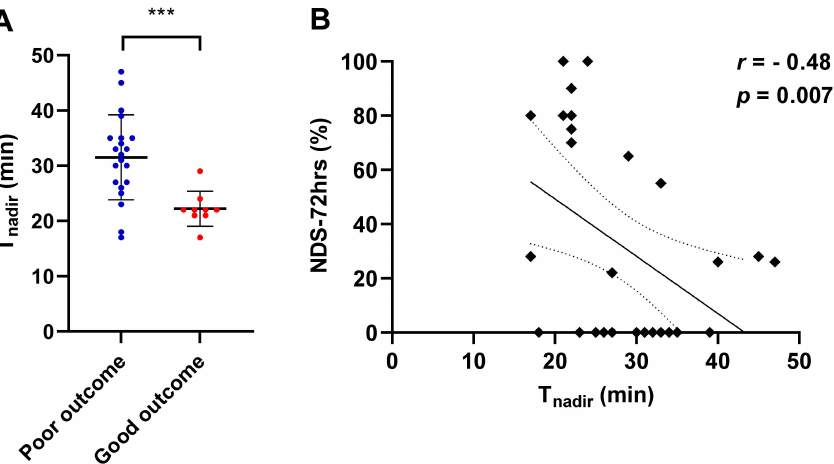
Figure 6. The association of T nadir with neurological function score (NFS) at 72 h post-return of spontaneous circulation. ( A ) Animals in the good outcome group exhibited a shorter T nadir than those in the poor outcome group (22.2 ± 3.2 min vs. 31.5 ± 7.7 min, *** p < 0.001). Closed circles indicate T nadir in each individual. The tentacles indicate mean ± SD in each group. ( B ). There was a significant negative correlation between T nadir and NFS at 72 h after return of spontaneous circulation (r = − 0.48; p = 0.007). Solid line indicates a correlation coefficient (r). Dashed lines show 95% confidence